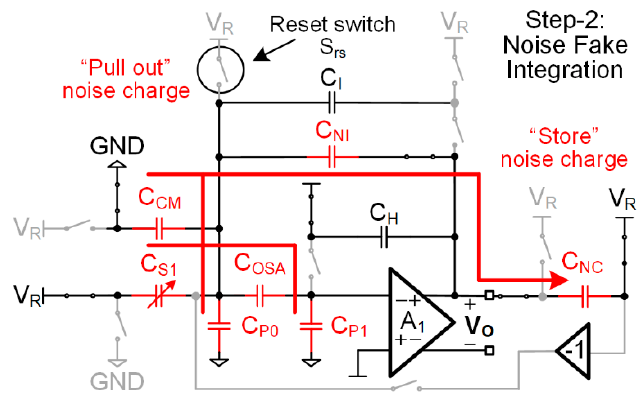
Figure 7. The noise fake integration of the reset noise sampling feedforward technique. Figure 6. The setting phase of the reset noise sampling feedforward technique. Figure 6. The setting phase of the reset noise sampling feedforward technique.